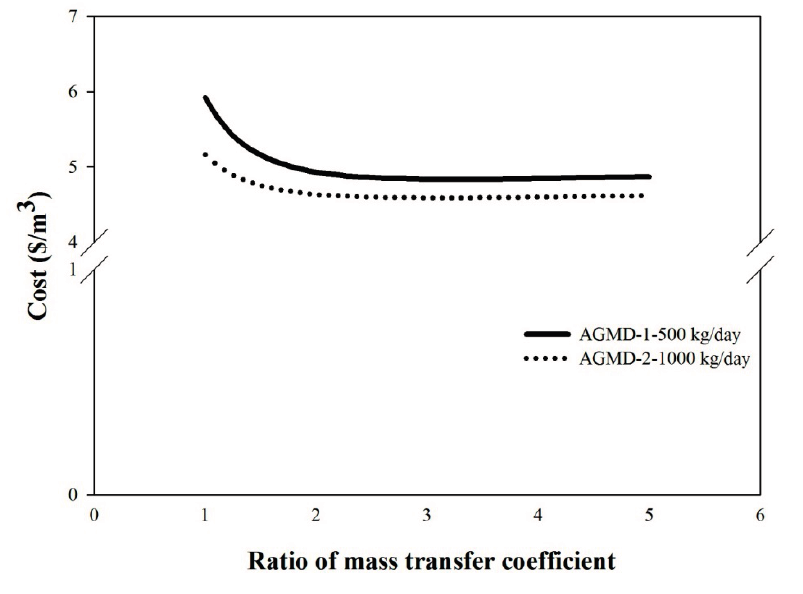
Figure 10. The effect of membrane mass transfer coefficient on unit production